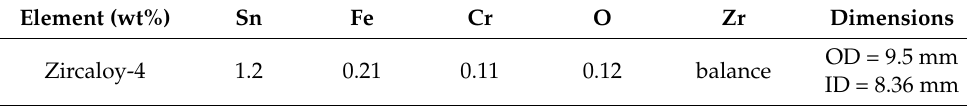
Table 1. Composition and dimensions of the Zircaloy-4